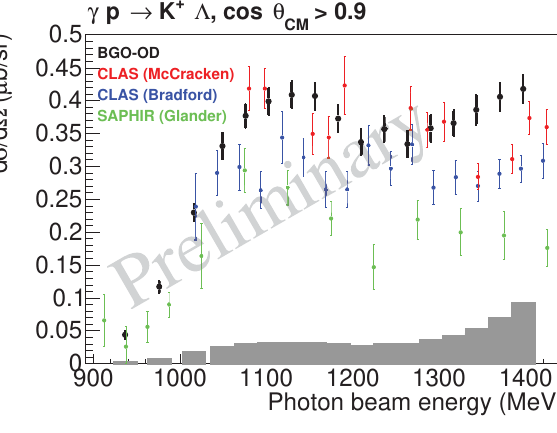
Figure 16. γ p → K + Λ di ff erential cross section for cos θ CM > 0 . 9 (Black points). Systematic errors are the filled grey bars on the abscissa. Previous data of McCracken [40], Bradford [41] and Glander [42] shown in red, blue and green respectively. The data of McCracken and Bradford are at the more backward inter- val, 0 . 85 < cos θ CM < 0 . 95.